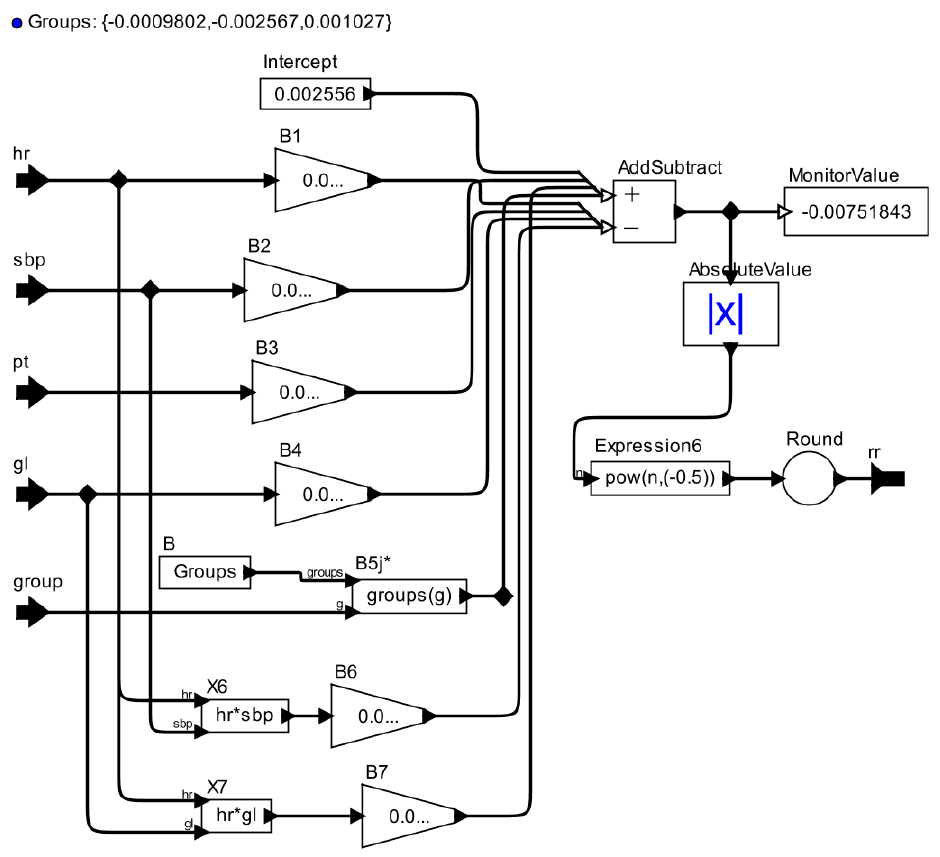
Figure 3. GLM_RR for the Patient